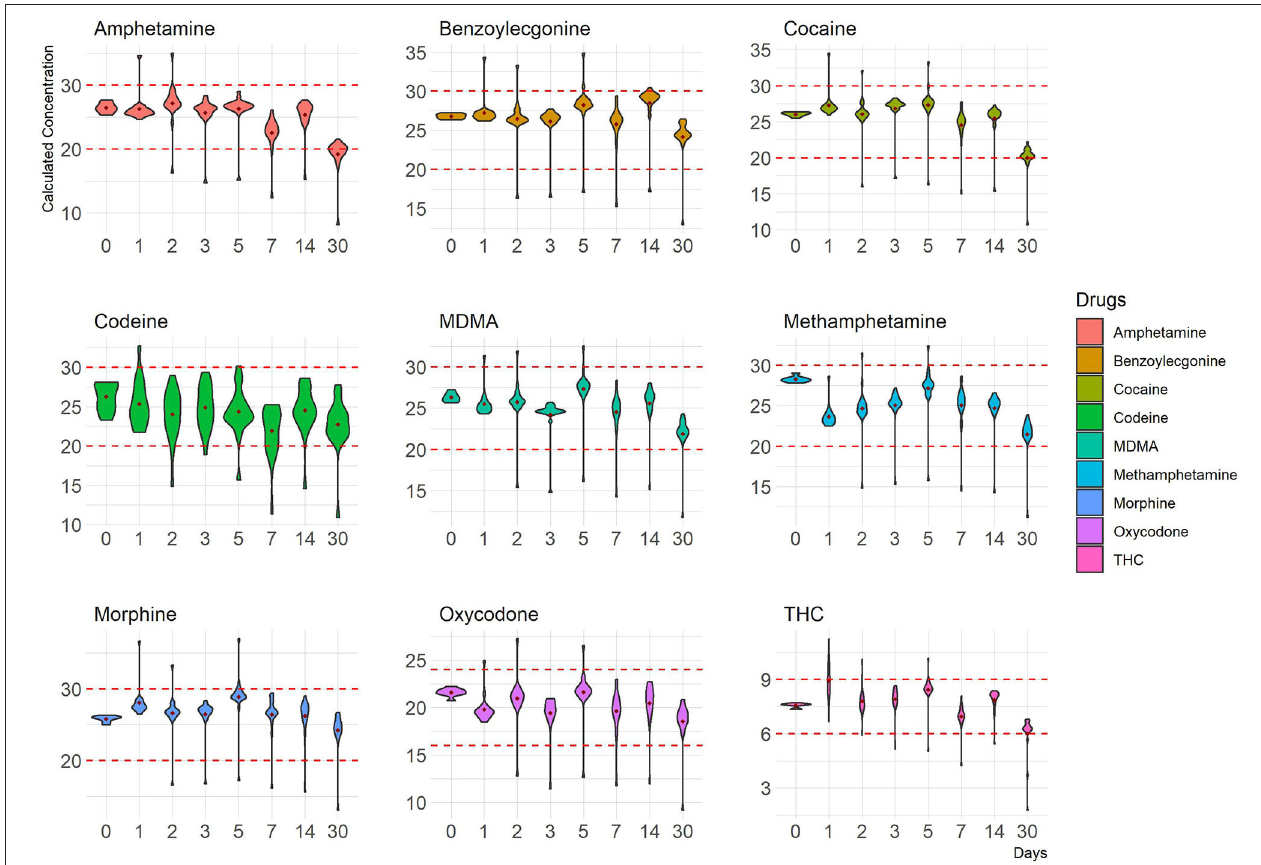
FIGURE 2 | Concentration distribution of replicate measurements (–50% cut-off) of nine drugs at 4 ◦ C is depicted as violin plots that outline kernel probability density, i.e., the width of the shaded colored area represents the proportion of the data located there. The y-axis represents calculated concentrations, and the x-axis represents time points in days. Red dotted lines represent ± 20%